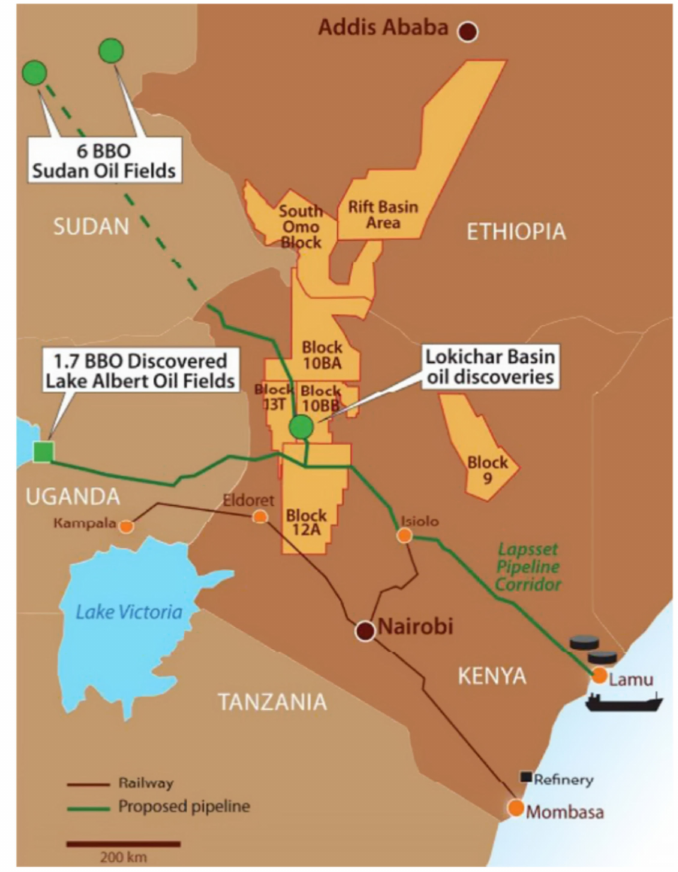
Figure 2. Location of the Lokichar Basin (green circle) and surrounding areas where oil has been discovered (Block 10BA, Block 13T, Block 10BB, Block 12A, and Block 9). The green straight line from Lamu port to Lake Albert represents a proposed pipeline route for transporting crude oil. Black circles represent major surrounding